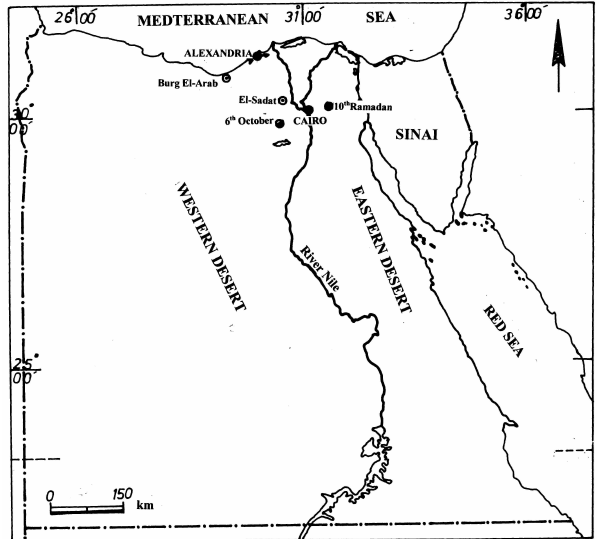
Fig. 1. Location map showing the four studied cities ( • ): 6 th October, El-Sadat, Burg El-Arab and 10 th